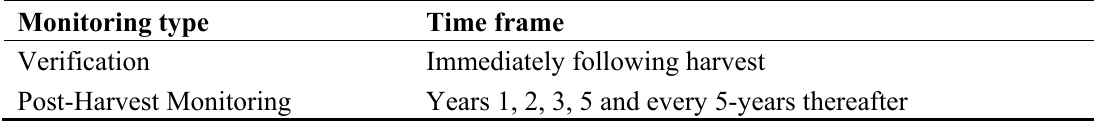
Table 2. Proposed Reduced-Impact Logging (RIL) carbon monitoring